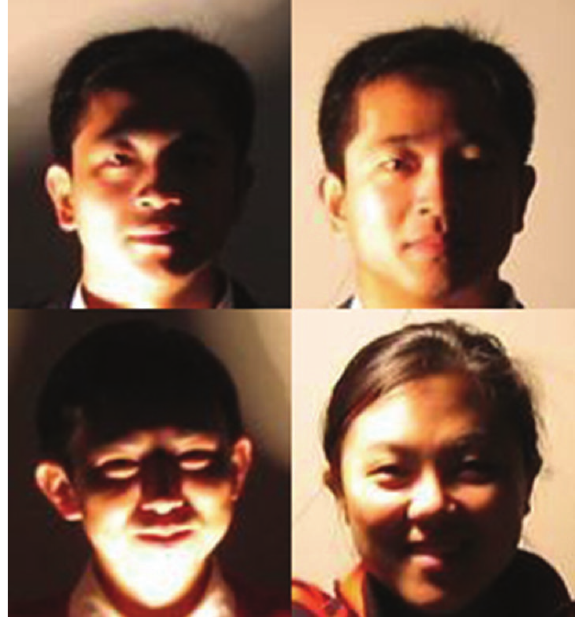
Figure 13: Example images from the small dataset collected by